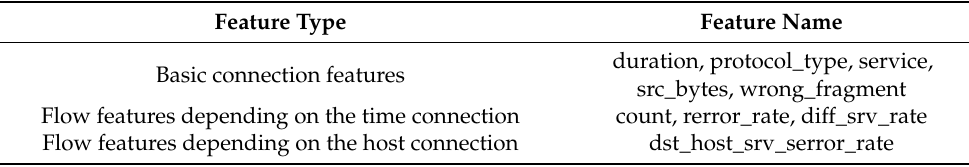
Table 10. SDN-related Features on the NSL-KDD dataset after feature selection.